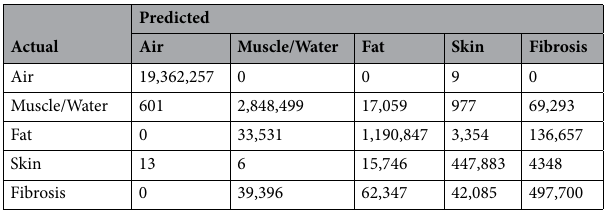
Table 1. Confusion matrix of the trained SegNet.